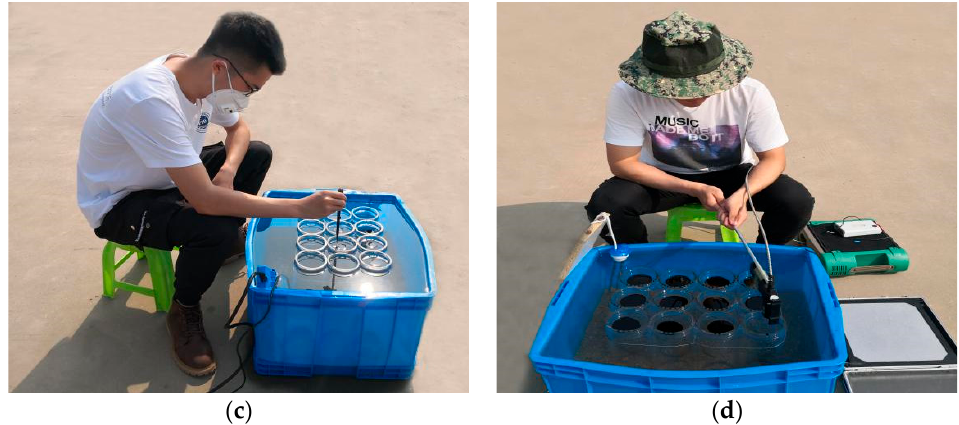
Figure 2. Photos of the field experiment. ( a ) Experimental container after adding oil. ( b ) Weighing crude oil mass. ( c ) Adding crude oil to the container. ( d ) Oil film spectral data measurement.